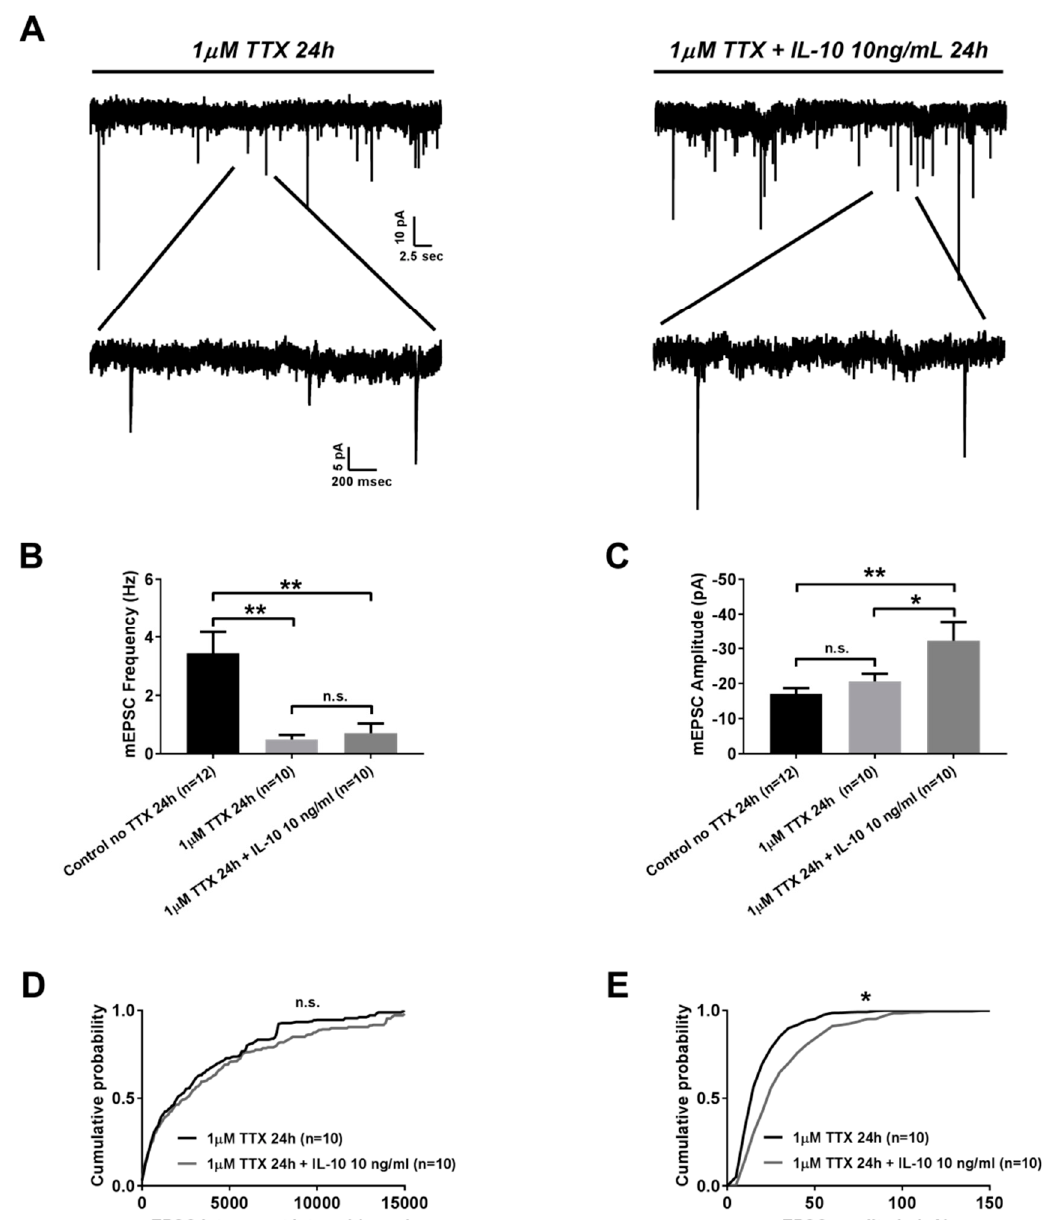
Figure 3. Co-treatment with IL-10 facilitates synaptic scaling in a model of homeostatic synaptic plasticity induced with 1 µM tetrodotoxin (TTX) treatment for 24 h. ( A ) Representative traces of mEPSC treated for 24 h ether with 1 µM TTX alone or 1 µM TTX co-incubated with 10 ng/mL IL-10. Traces are presented at different time scales. Each condition is highlighted with a solid line. ( B ) Graphical bars representing mEPSC frequency in control and at 24 h treatment with 1 µM TTX or 1 µM TTX co-incubated with 10 ng/mL of IL-10. ( C ) Graphical bars representing mEPSC amplitude in control and at 24 h treatments with 1 µM TTX or 1 µM TTX co-incubated with 10 ng/mL of IL-10. ( D ) and ( E ) Cumulative probability distribution plots representing mEPSC inter-event interval ( D ) and amplitude ( E ) distribution in neurons treated for 24 h with 1 µM TTX or 1 µM TTX co-incubated with 10 ng/mL of IL-10. * p < 0.05 or ** p < 0.01 with ANOVA followed by a Bonferroni posthoc test; * p < 0.05 with Kolmogorov–Smirnov test (for E ).